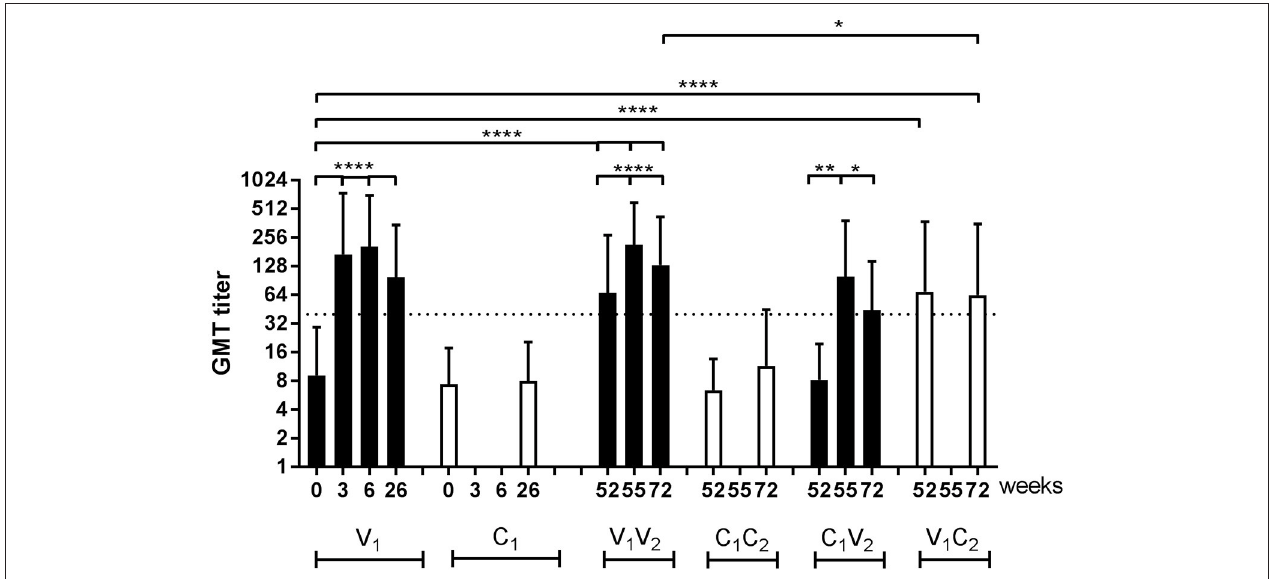
FIGURE 3 | HI titers of influenza virus-specific antibody responses. Geometric mean titer (GMT) with SD of A(H1N1)pdm09-specific antibodies in vaccinated individuals and individuals of the control group of the per protocol group during season 1 and season 2. Antibody responses were tested with paired T test for longitudinal samples of individuals in the same group and unpaired T test with Welch’s correction for analysis of samples from different groups. (cid:4) vaccinated (cid:3) controls ... protective antibody level of 40 * P < 0.05, ** P < 0.01, **** P < 0.0001,N.A. not